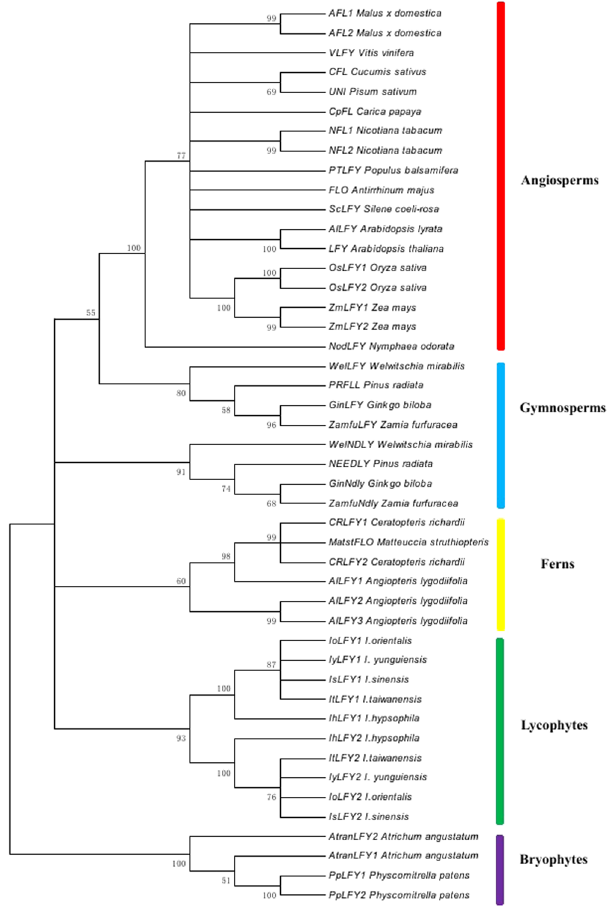
Figure 3. Phylogenetic tree of LFY homologs. The phylogenetic tree was constructed using the amino acid sequences of LFY homologs. Numbers above the branches represent bootstrap value, and bootstrap less than 50% was removed. Accession numbers for the LFY homologs in the dataset were listed in Table